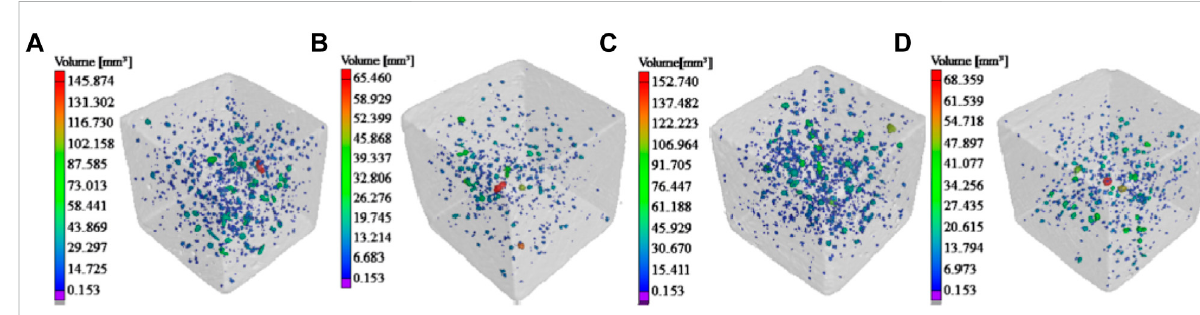
FIGURE 9 Pore graph of fi nal erosion states of concrete test specimens; (A) GSa; (B) GSb; (C) GSc; (D) GSd.